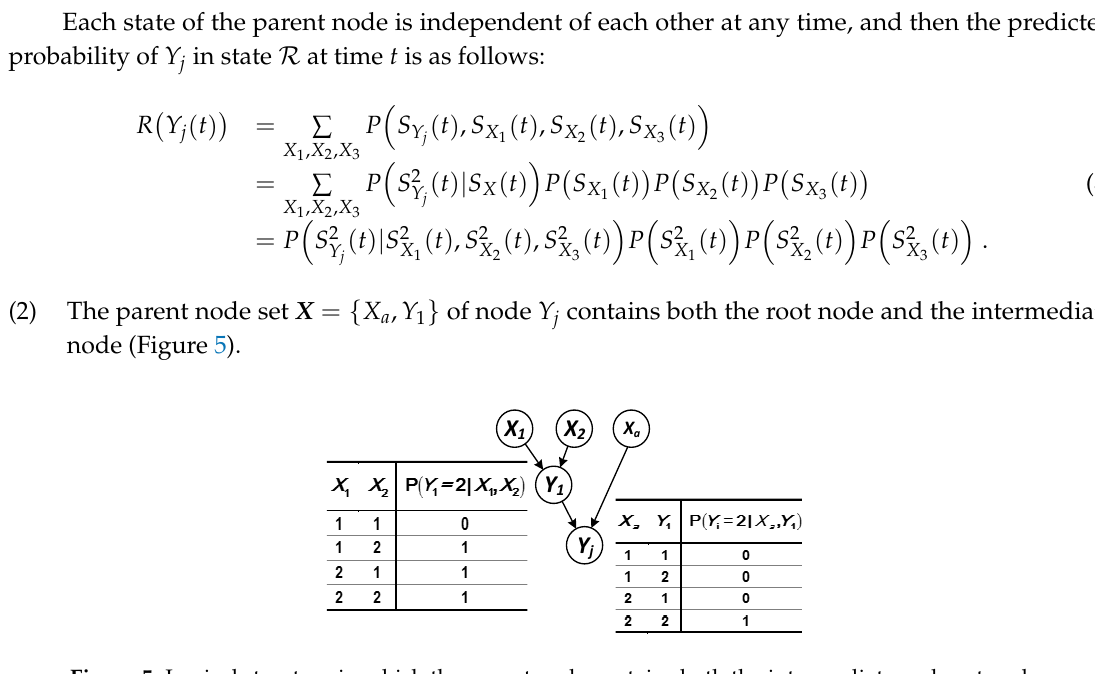
Figure 4. Logical structure in which the parent node is the root node.